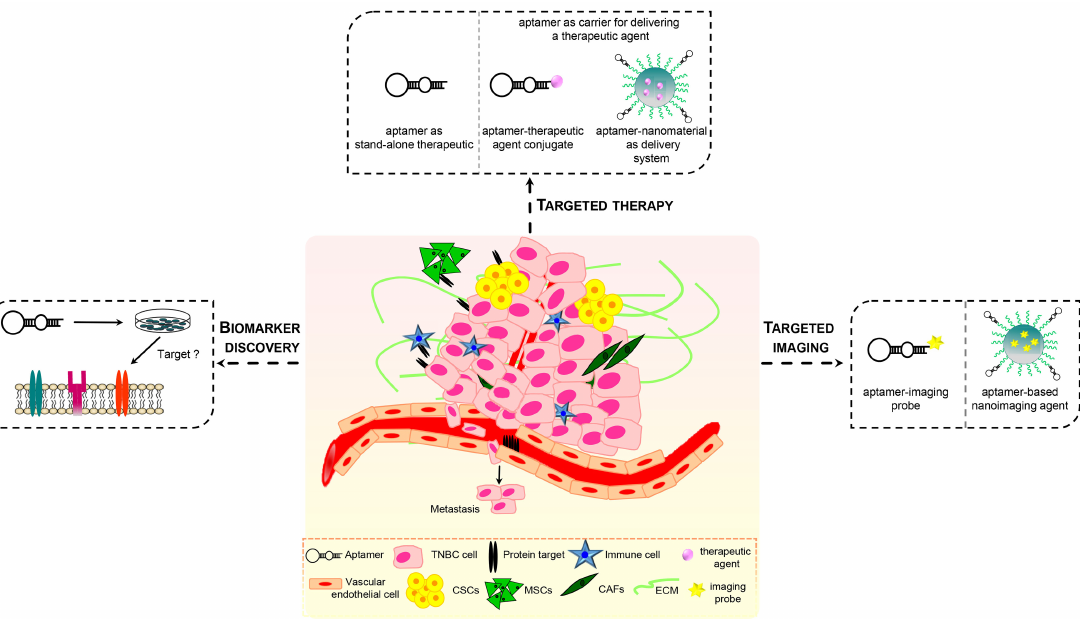
Figure 2. Applications of aptamers in TNBC. Aptamers against targets, which have a crucial role in TNBC and surrounding microenvironment, may serve as therapeutics, by modulating target’s function or delivering other therapeutic agents (chemotherapeutics, small therapeutic oligonucleotides), imaging agents and targeting agents for biomarkers